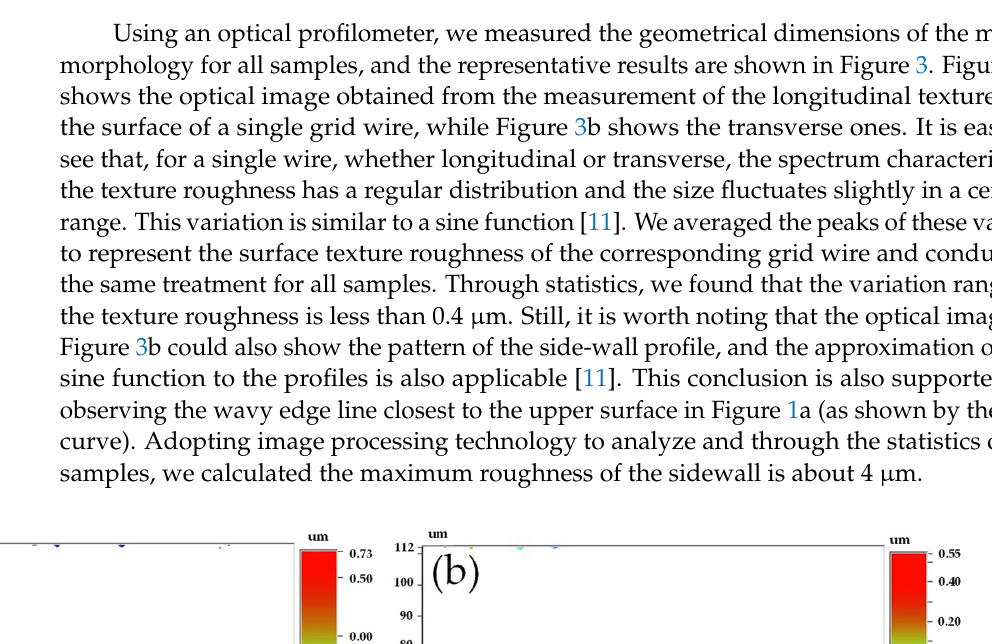
Figure 2. 3D model of a single grid measured by a Zego interferometer.